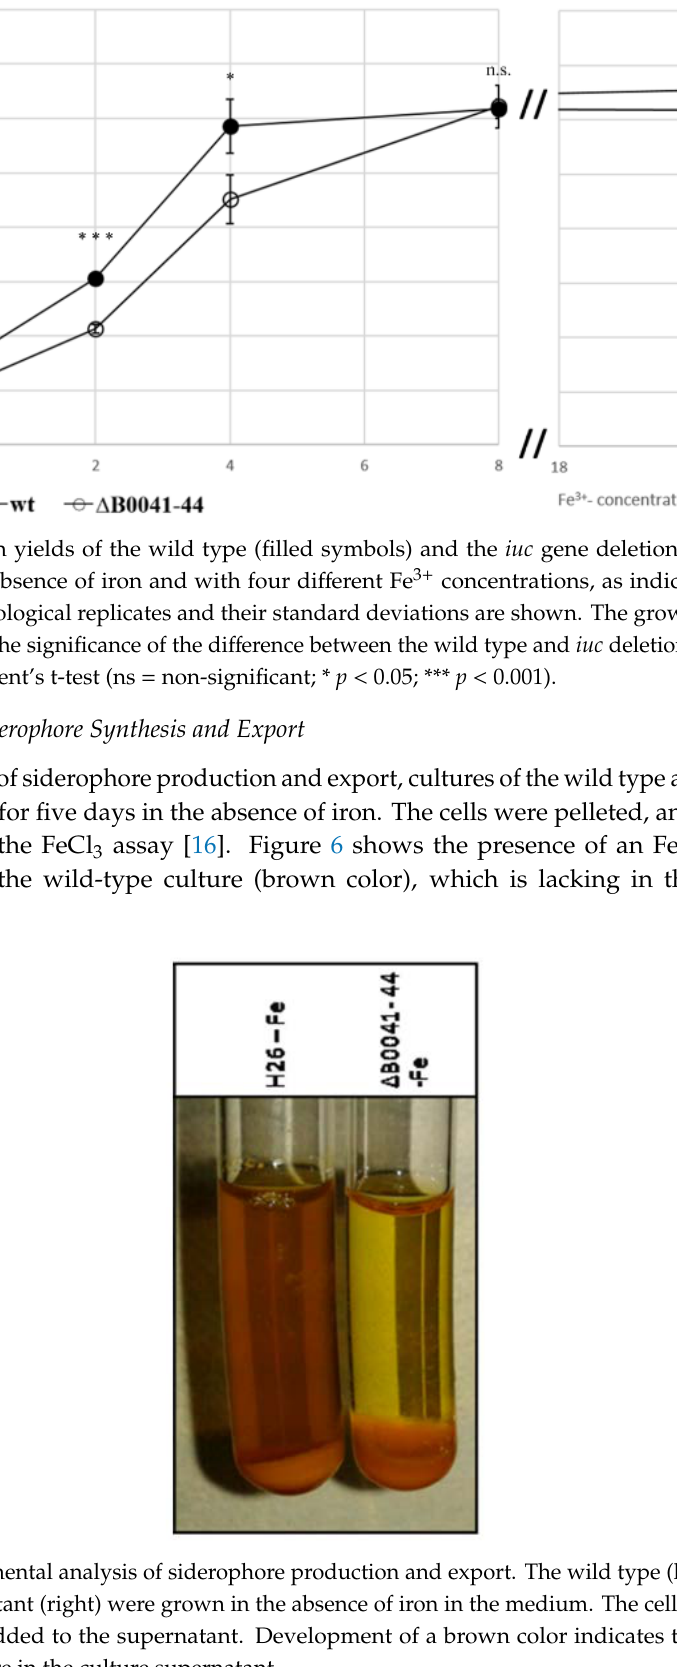
Figure 7. Overlay CAS (O-CAS) assay for the production and export of a Fe 3+ siderophore. Tenfold dilutions of the cell cultures of the wild type ( left ) and the iuc gene deletion mutant ( right ) were spotted onto agar plates. The number of cells that were spotted is indicated in the rightmost column. The plates were either devoid of iron ( top ) or contained 8 µM iron ( bottom ). After four days of growth the plates were overlaid with a solution containing Fe 3+ and the CAS reagent. Development of a blue-green color indicated the presence of free Fe 3+ , while retention of the yellow color of the medium indicates the lack of free iron, either because it was complexed by a Fe 3+ siderophore (top left) or because it was taken up by the cells of the colonies ( bottom ).